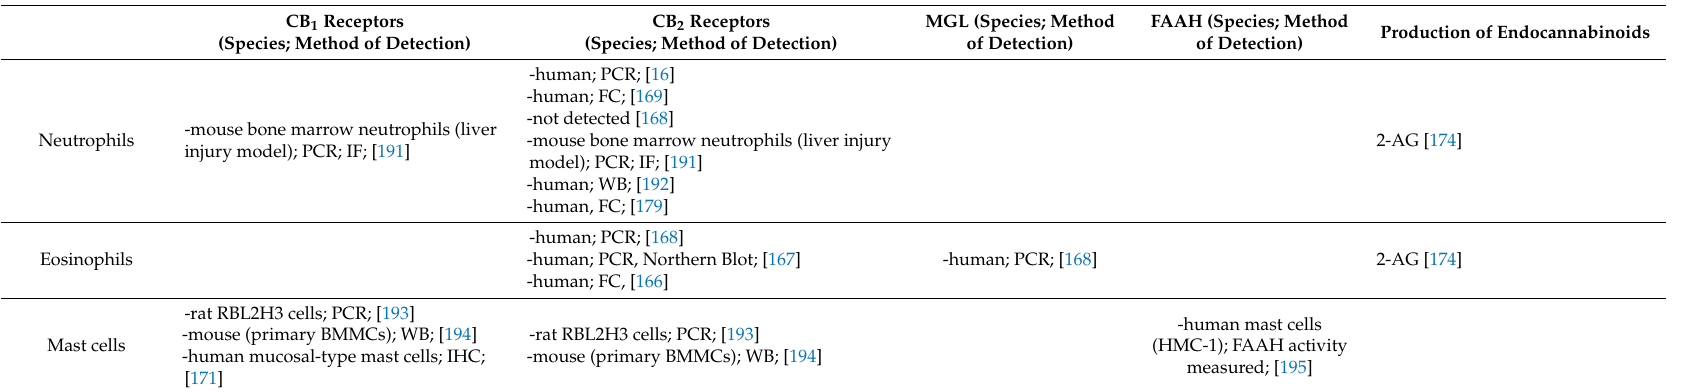
CB 1 Receptors (Species; Method of Detection)